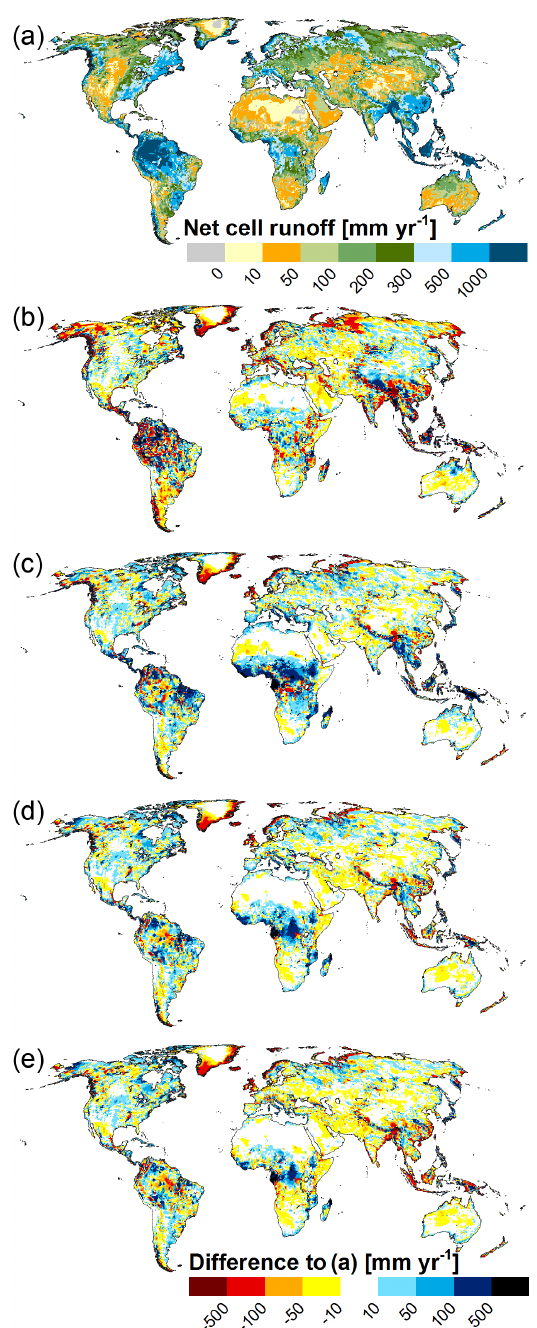
Figure 1. Long-term (1971–2000) average net cell runoff of the model variants, displayed as absolute numbers for GSWP3 (a) and differences to the other forcings, computed as PGFv2 mi- nus GSWP3 (b) , WFD minus GSWP3 (c) , WFD_WFDEI minus GSWP3 (d) and WFDEI_hom minus GSWP3 (e) . Negative values in (a) indicate that water inflow into cell from upstream and by pre- cipitation is larger than outflow due to evaporation from surface wa- ter bodies. All units in mmyr − 1